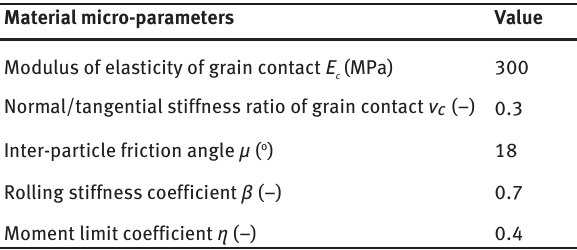
Figure 5: Vertical normal stress σ from discrete simulations of homogeneous triaxial compression test for different initial void ratios e